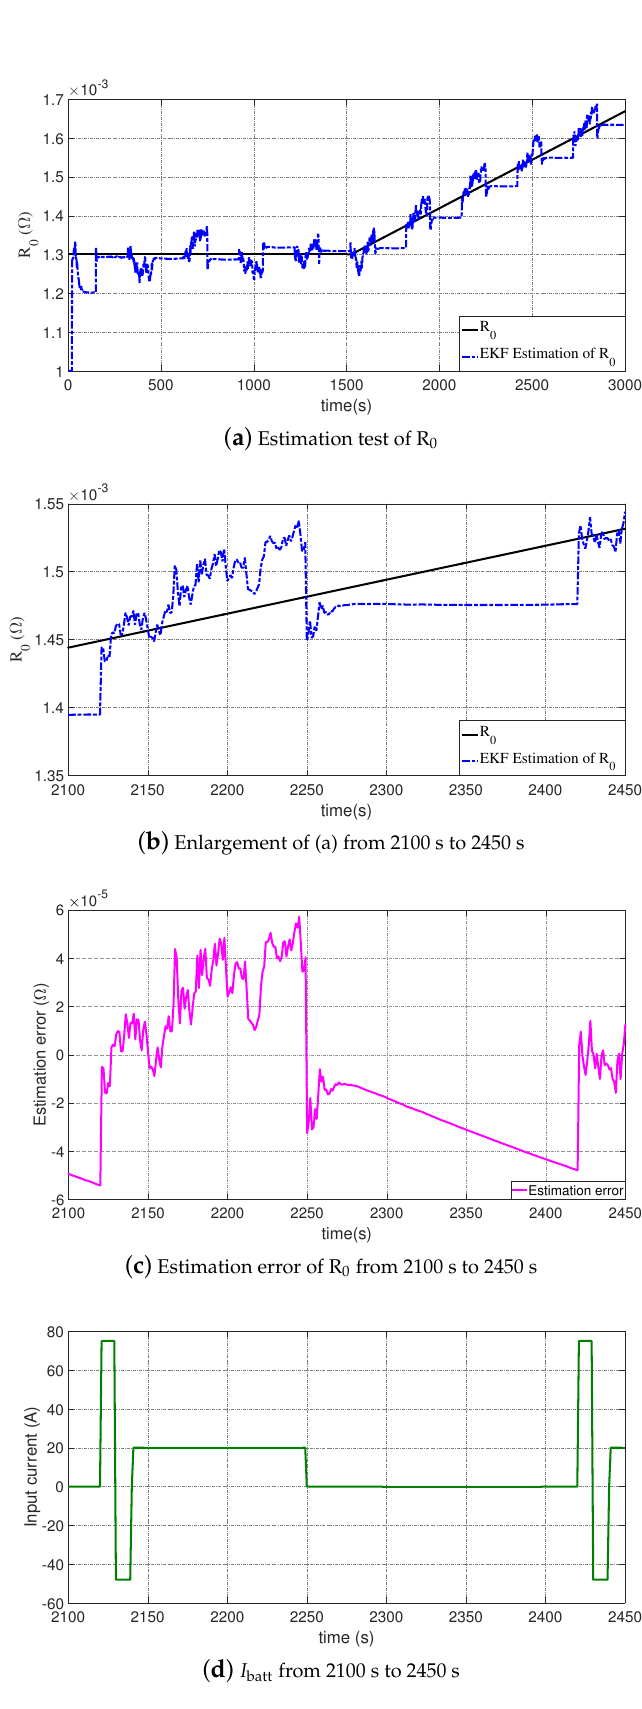
Figure 9. Verification of the time varying behavior of I batt on the estimation of ECM